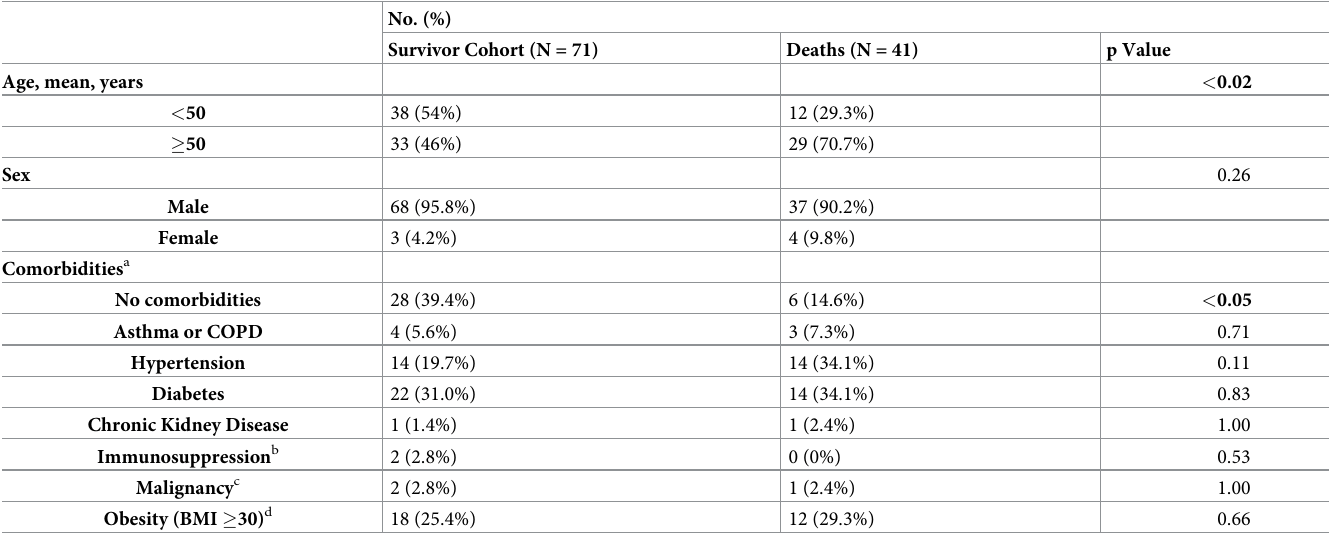
Table 3. Comparison of characteristics of COVID-19 survivors and